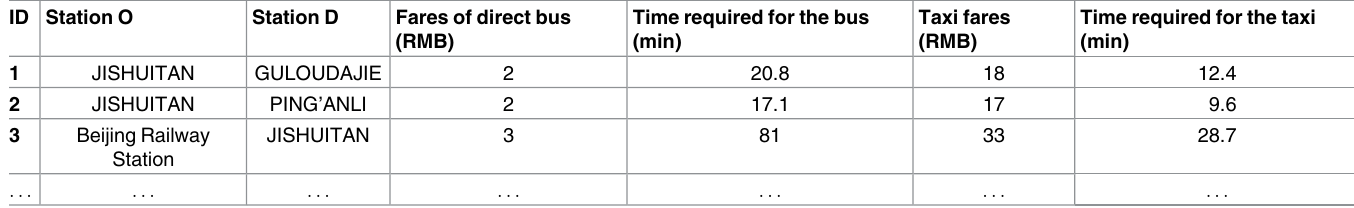
Table 2. Example of expected fare and time consumption of buses and taxis between each pair of rail stations.